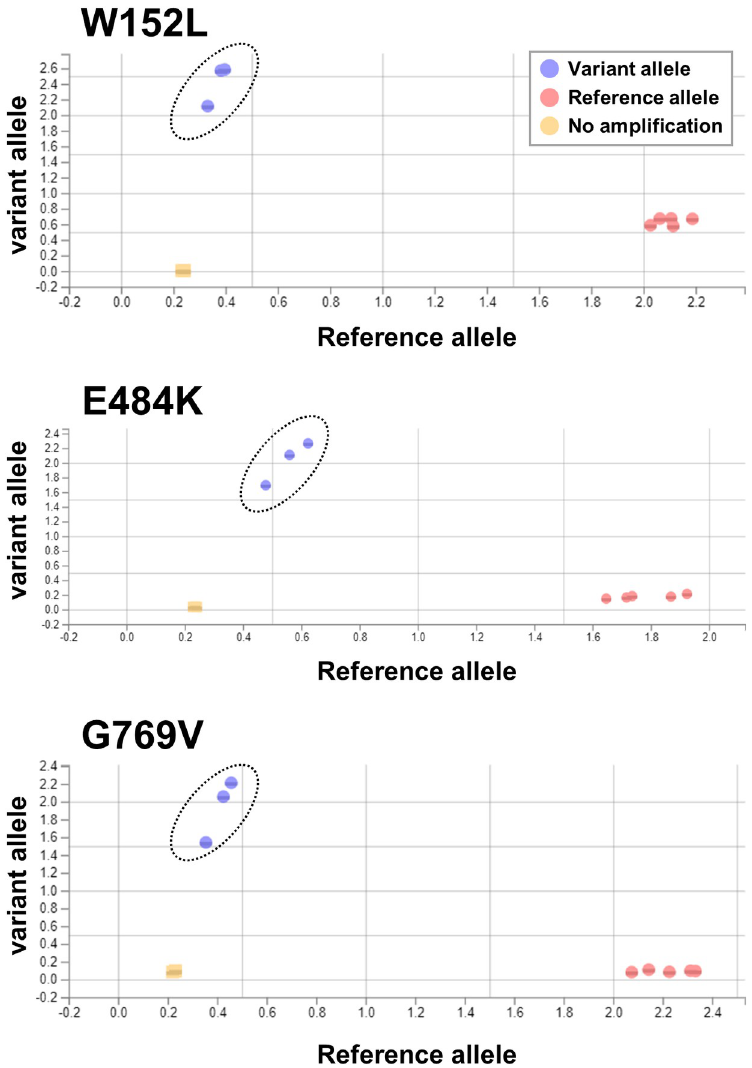
Fig 1. TaqMan assay for discriminating R.1 lineage SARS-CoV-2 by its spike variant allele. We analyzed samples of R.1 lineage SARS-CoV-2 (n = 3), which harbors a spike variant with the W152L/E484K/G769V mutations and samples of SARS-CoV-2 without these three mutations (n = 5) using a TaqMan assay. An allelic discrimination plot of the results, showing the spike variants with W152L (upper), E484K (middle), and G769V (lower). The dots indicate the mutant alleles (purple), reference allele (pink), or no amplification (orange). The dotted circles indicate the mutant alleles of each